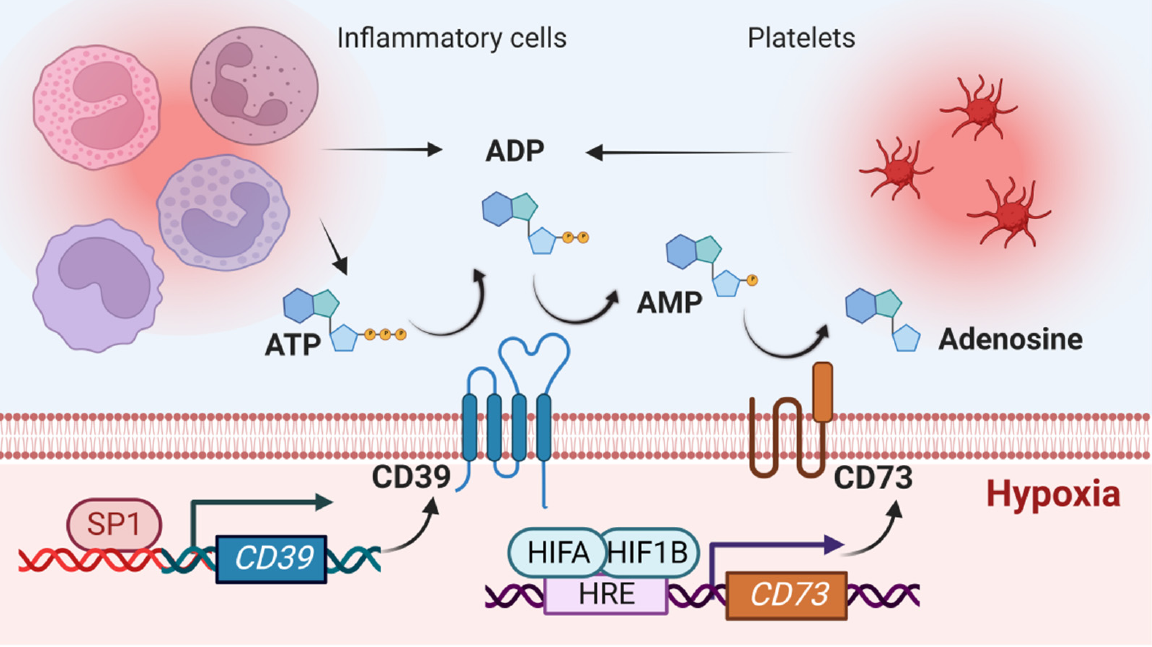
Figure 1. Hypoxia increases extracellular adenosine during myocardial ischemia. In the context of hypoxia, different cell types such as inflammatory cells and platelets release large amounts of adenine nucleotides (particularly ATP or ADP). The ectonucleotidases CD39 and CD73 convert ADP/ATP to AMP and AMP to adenosine, respectively. Therefore, the level of extracellular adenosine during hypoxia or inflammation critically depends on the expression level and enzymatic activity of CD39 and CD73. Hypoxia promotes the induction of CD39 expression through SP1 signaling, and of CD73 expression through binding of the transcription factor hypoxia-inducible factor HIF1A to a hypoxia-response element (HRE) within the CD73 promoter. ATP: adenosine triphosphate; ADP: adenosine diphosphate; AMP: adenosine monophosphate.